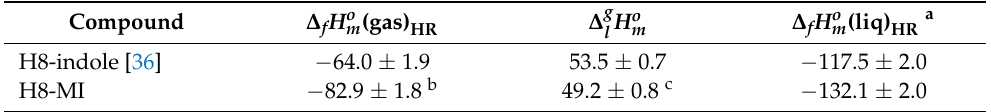
Table 8. Liquid phase enthalpies of formation, ∆ (cid:2916) 𝐻 mo (liq), of the hydrogen-lean counter-parts, at T =